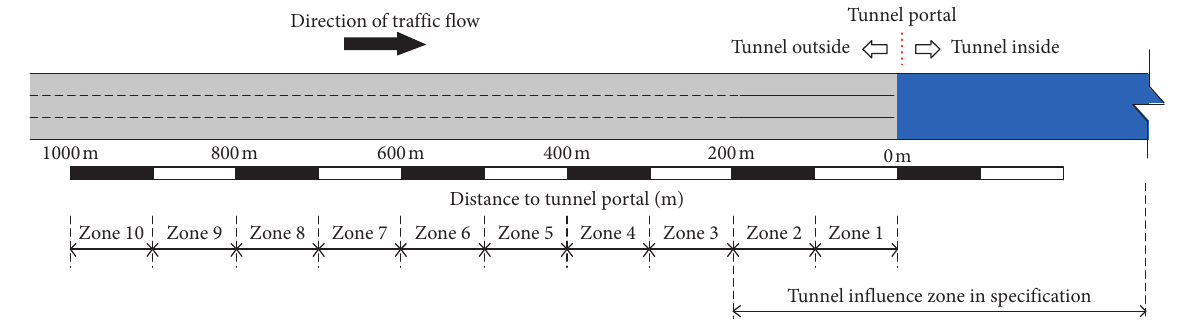
Figure 7: Division of zones before the tunnel portal. Table 3: Statistical results for the number of fixations.